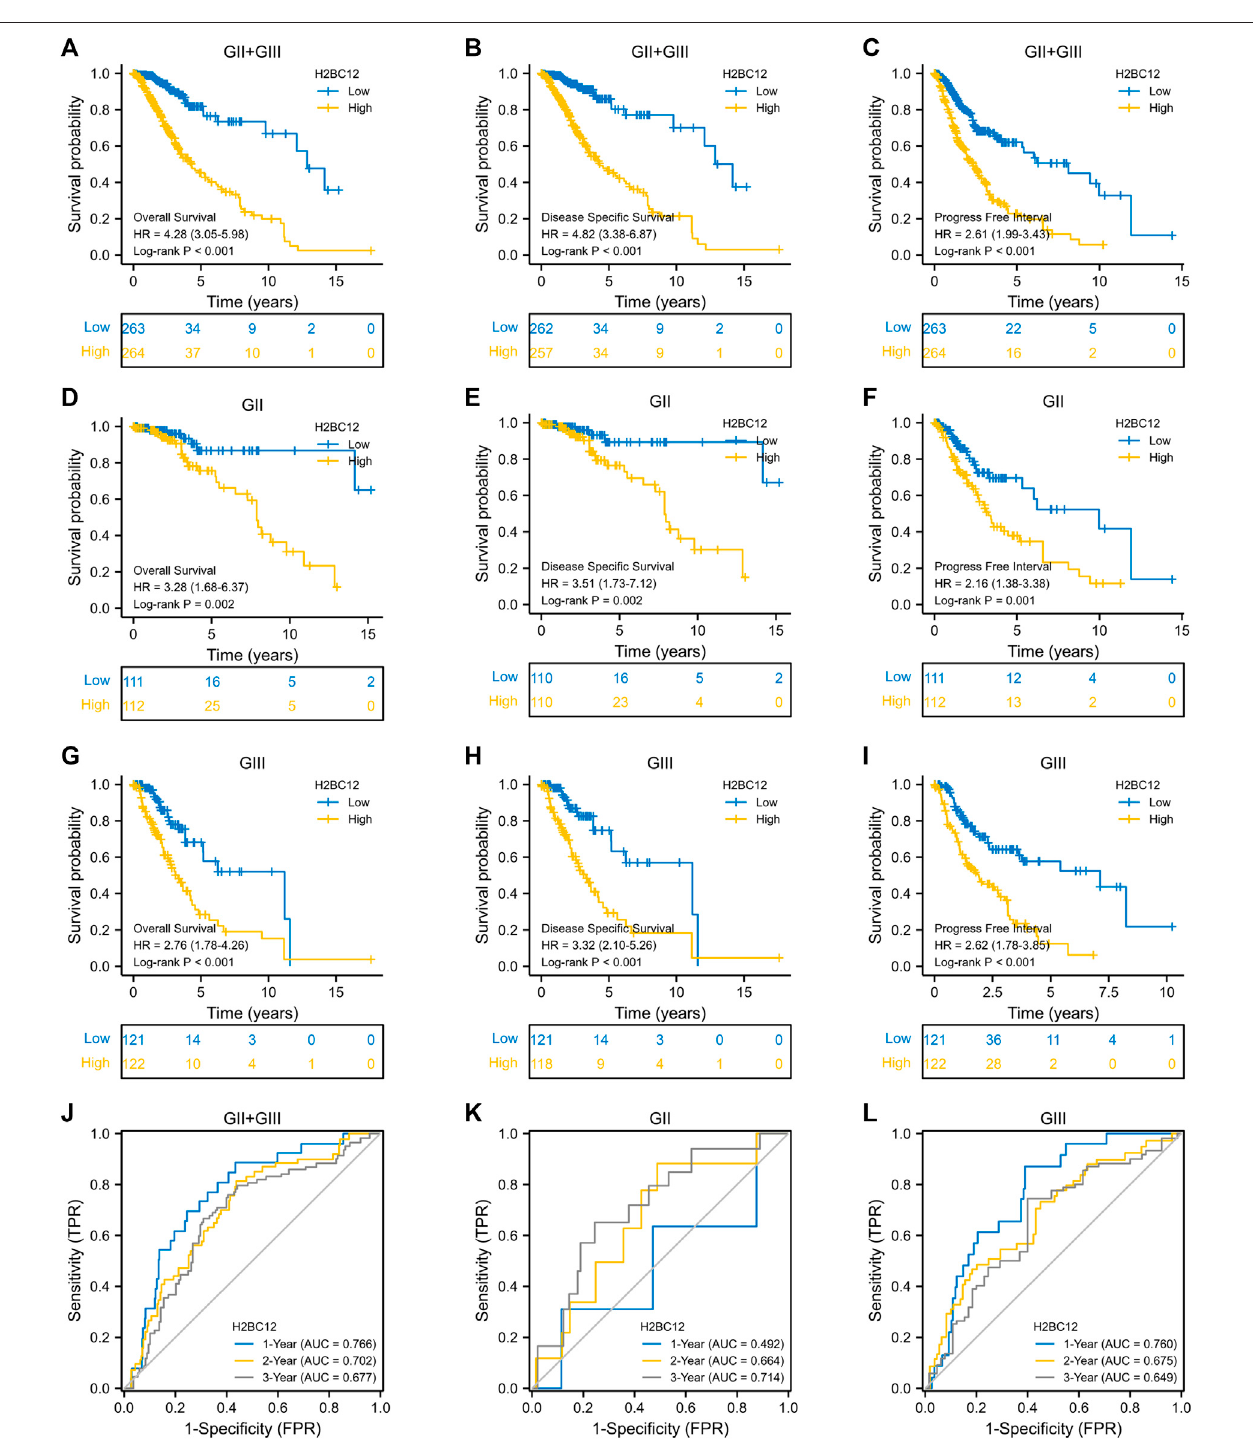
FIGURE 3 | High expression of H2BC12 is associated with poor OS, DSS, and PFI in patients with GII and/or GIII. OS (A) , p < 0.001, DSS (B) , p < 0.001, and PFI (C) ,p < 0.001weresigni fi cantlypoorerinGII+GIIIpatientswithhighH2BC12expressionthanthosewithlowH2BC12expression.Furthermore,OS,DSS,andPFIofGII (D – F) and GIII (G – I) were analyzed respectively. OS, Overall Survival; DSS, Disease-Speci fi c Survival; PFI, Progress-Free Interval. (J) tROC curve demonstrated AUC values for 1-, 2-, and 3-years survival in GII + GIII as 0.766, 0.702, and 0.677, respectively. The 1-, 2-, and 3-years AOC values in GII were 0.492, 0.664, and 0.714 (K). The 1-, 2-, and 3-years AOC values in GIII were 0.760, 0.675, and 0.6499 (L) .